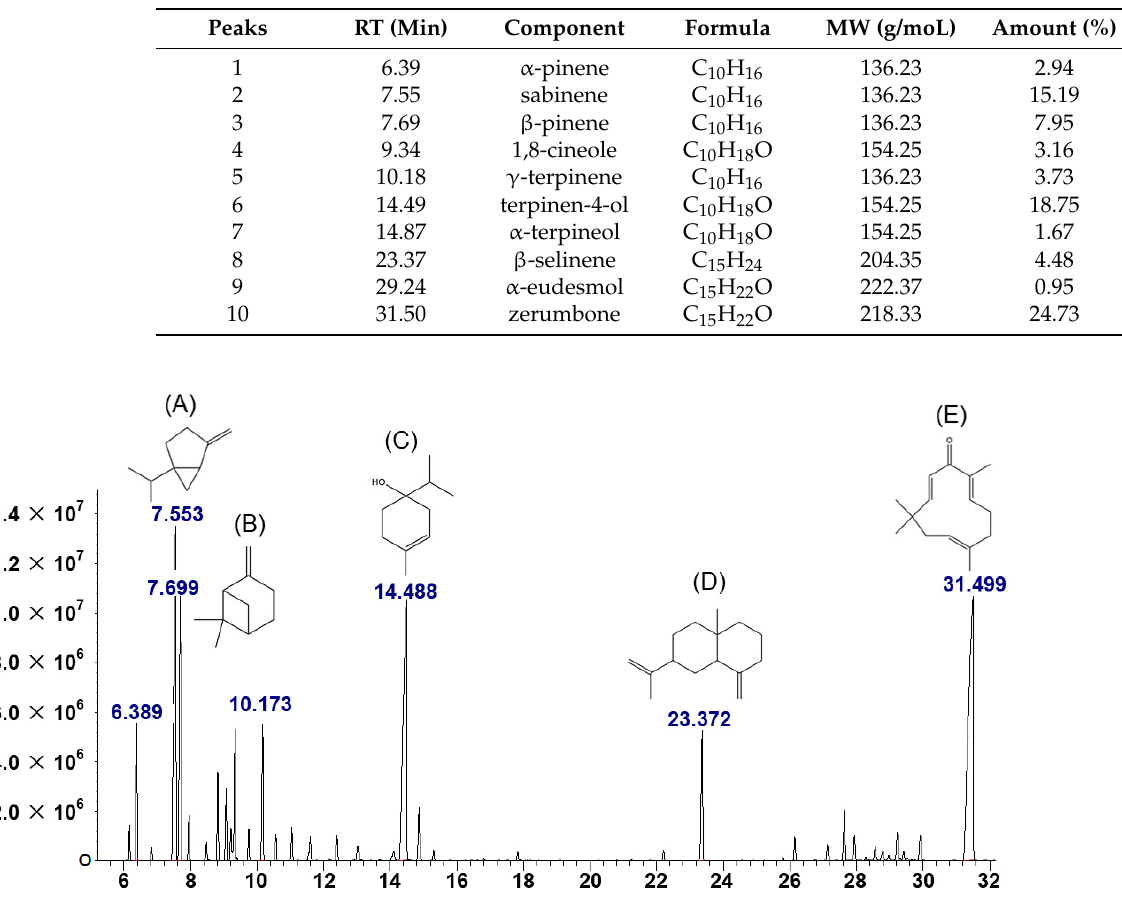
Table 1. Chemical composition of essential oil from Zingiber ottensii (ZO) Valeton identified by GC–MS analysis. The ZO essential oil was extracted from the rhizomes of ZO by simultaneous steam distillation and analyzed by GC–MS. RT: Retention time; MW: molecular weight.